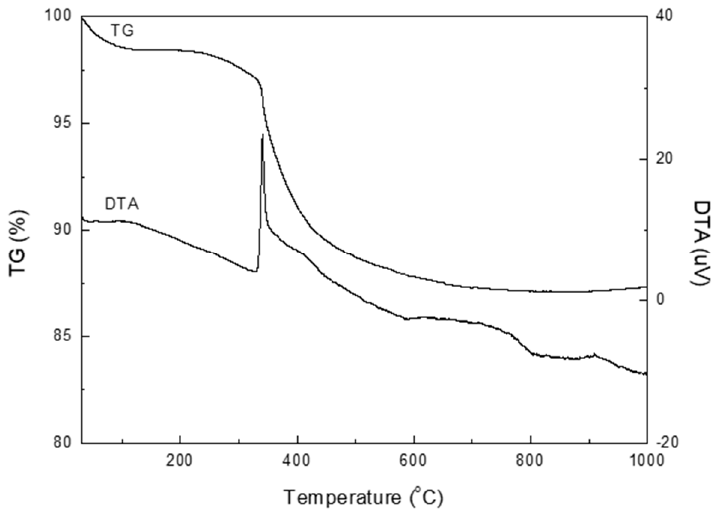
Figure 9. TG and DTA curves of the silica aerogel at 30–1000 °C in air.